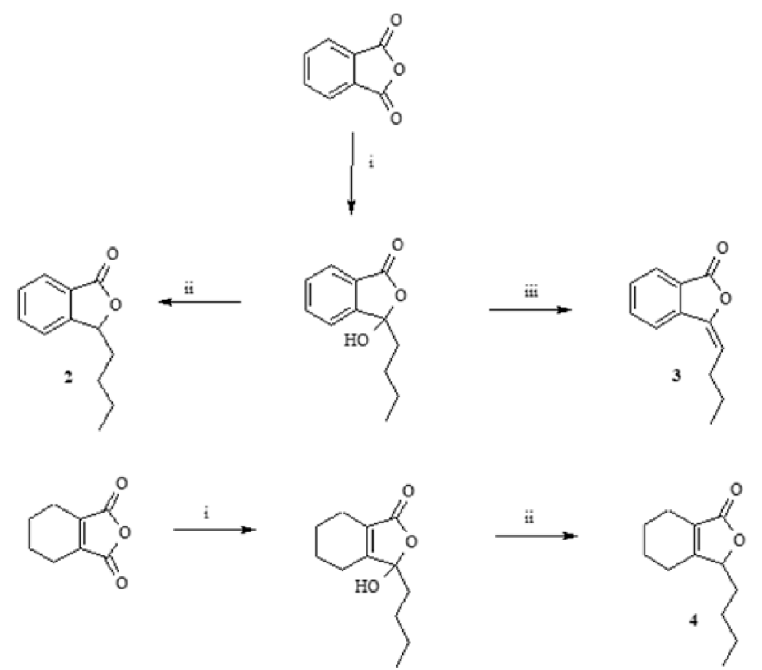
Figure 2. Scheme of synthesis of phthalide lactones 2–4 . i—Et 2 O, Mg, n-C 4 H 9 Br, CdCl 2 ; ii—THF, NaBH 4 ; iii—toluene, TsOH.